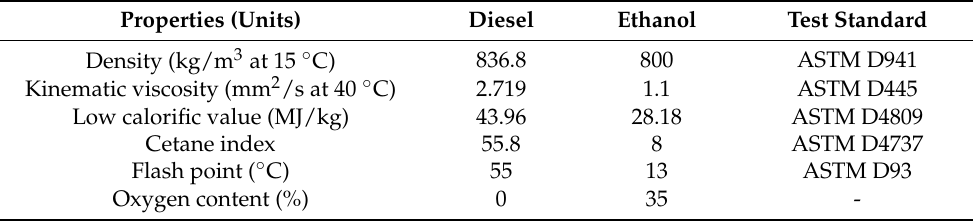
Table 1. Main fuel properties. Properties